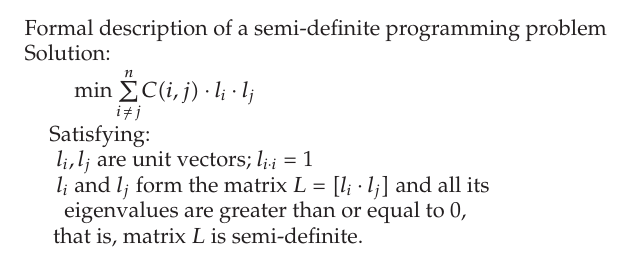
Algorithm 1: Formal